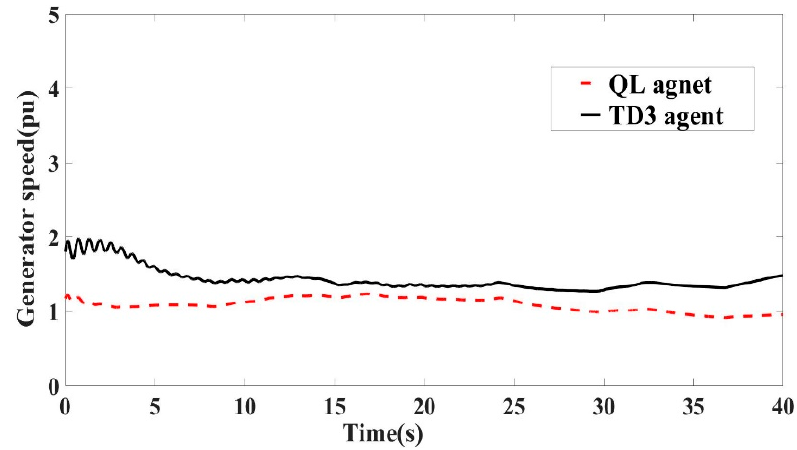
Figure 33 . Generator speed with TD3 agent vs. Q ‐ learning. Figure 33. Generator speed with TD3 agent vs.